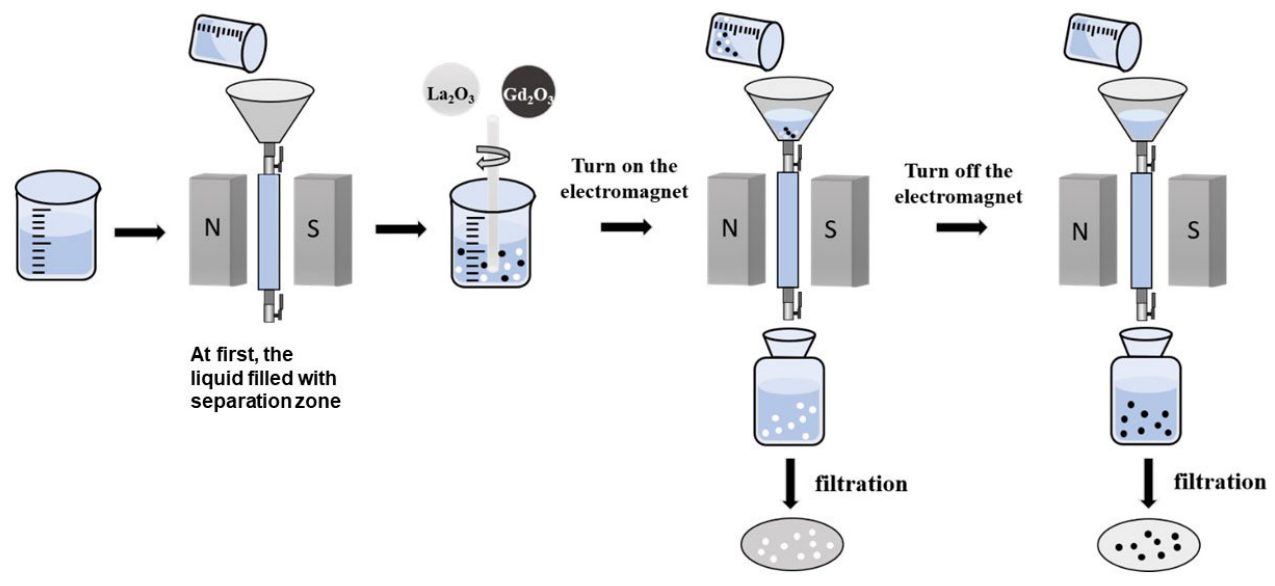
Figure 3. Experimental procedure of the HGMS method.